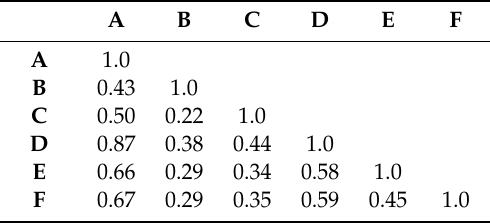
Table 7. The correlation coe ffi cients on winter among the seasonal Weibull distributions of the six farms. A B C D